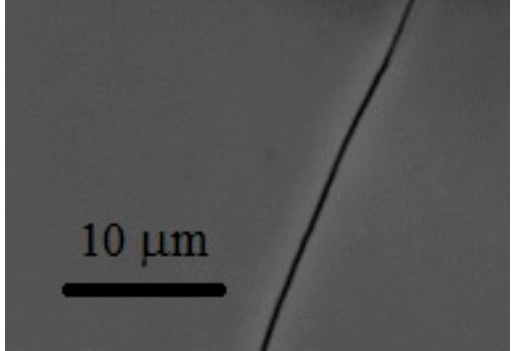
Figure 3. SEM micrographs (magnification 5000×) of DC3.